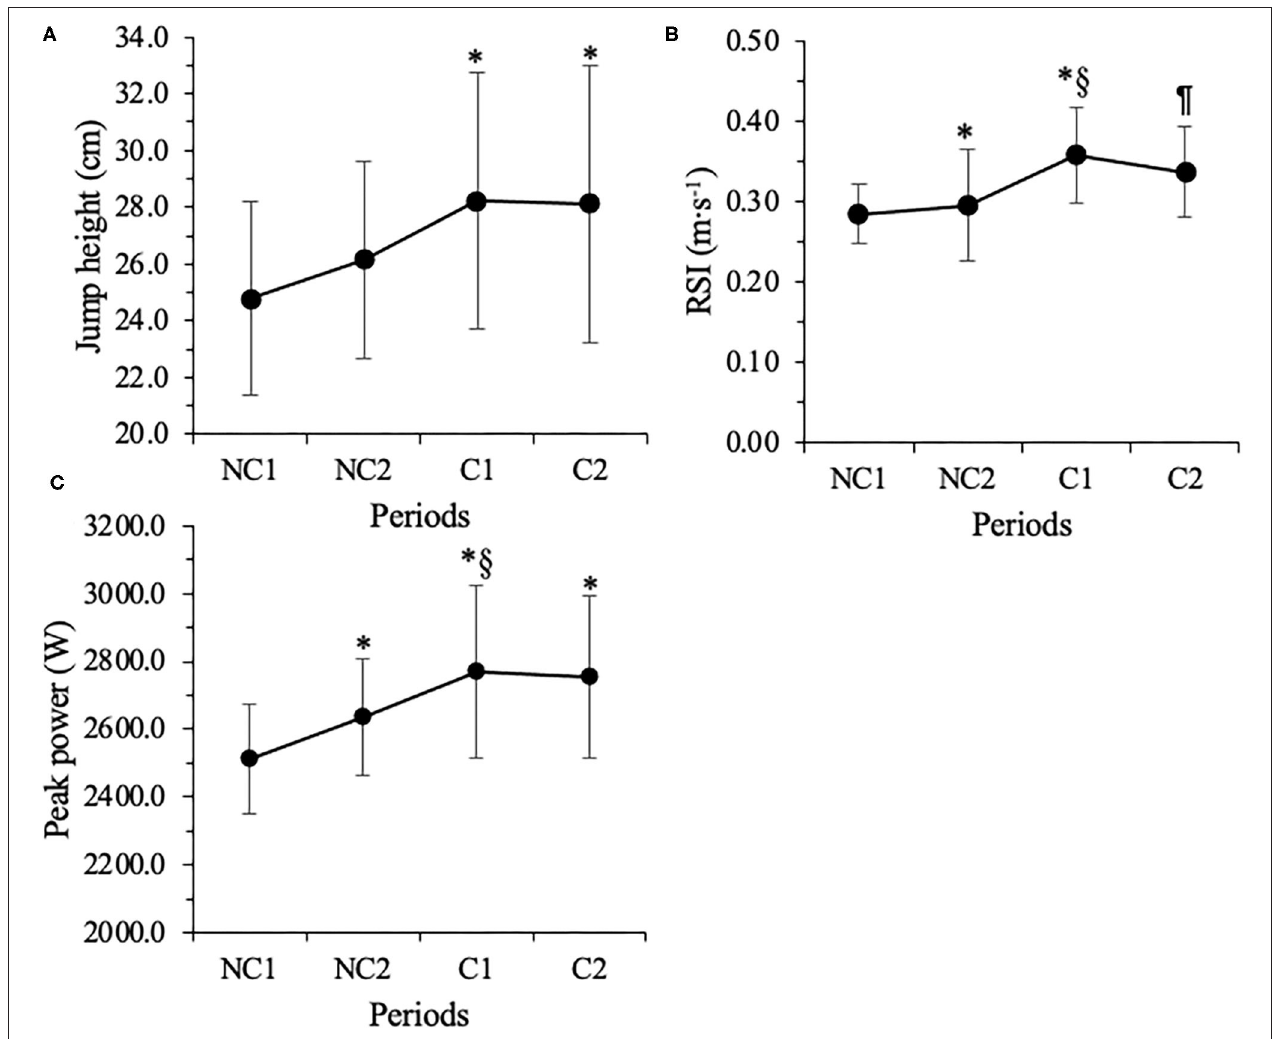
FIGURE 1 | Seasonal changes in unloaded countermovement jump height (A) , modified strength index (RSI) (B) , and peak power (C) . NC 1 = 1st non-conference match-play. NC 2 = 7th non-conference match-play. C 1 = 1st conference match-play. C 2 = 6th conference match-play. *Denotes p ≤ 0.05 from NC 1 . § Denotes p ≤ 0.05 from NC. ¶ Denotes p ≤ 0.05 from C 1 .